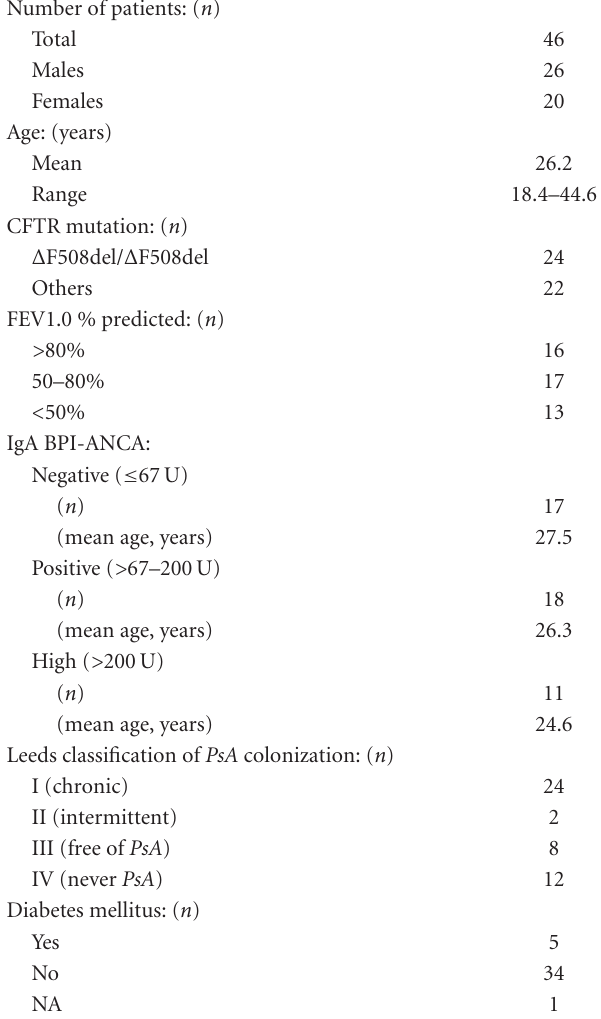
Table 1: Characteristics of the adult CF cohort at the time of BPI- ANCA sampling